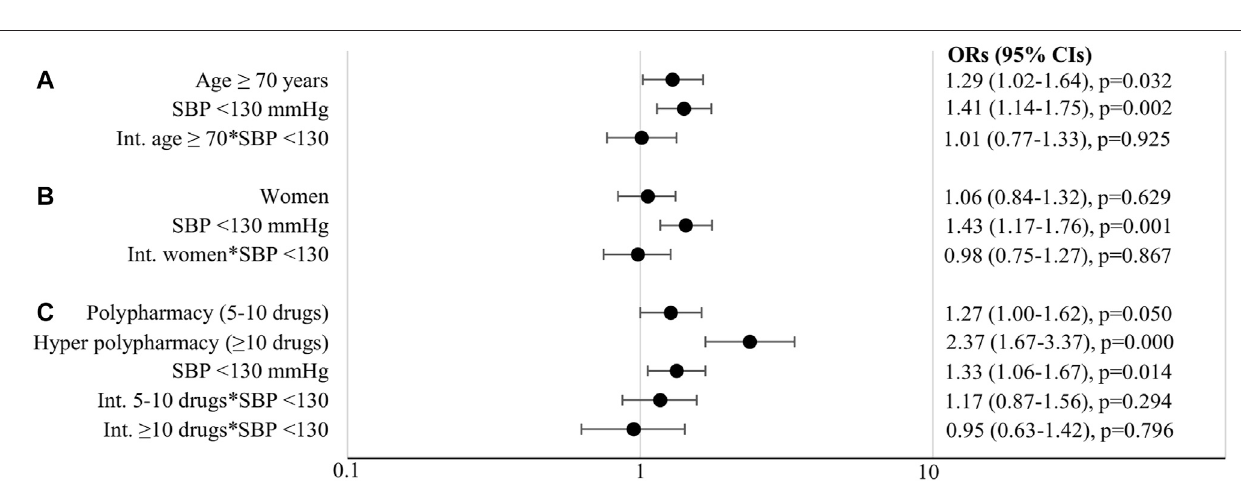
FIGURE 2 | Odds ratios (OR) with 95% con fi dence intervals (CIs) and p -values for (A) age, (B) sex, (C) polypharmacy, with systolic blood pressure (SBP) and their interactions. Age and sex analyses were adjusted for glycated hemoglobin A1c, diabetes duration, body mass index, smoking, diastolic blood pressure, estimated glomerular fi ltrationrate,glucoseloweringtherapy,dyslipidemia,lipidloweringtherapy,albuminuria,numberofcomedicationandsexorage;polypharmacyanalysiswas adjusted for the same variables except for glucose and lipid lowering therapy. Int., interaction.